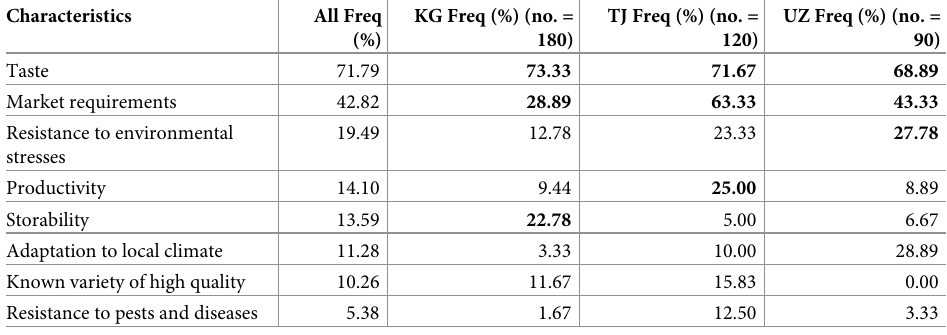
Note: Frequencies are proportions of respondents per country who cited a given characteristic. Multiple responses were possible, hence frequencies add up to more than 100% per country. KG: Kyrgyzstan, TJ: Tajikistan, UZ: Uzbekistan.